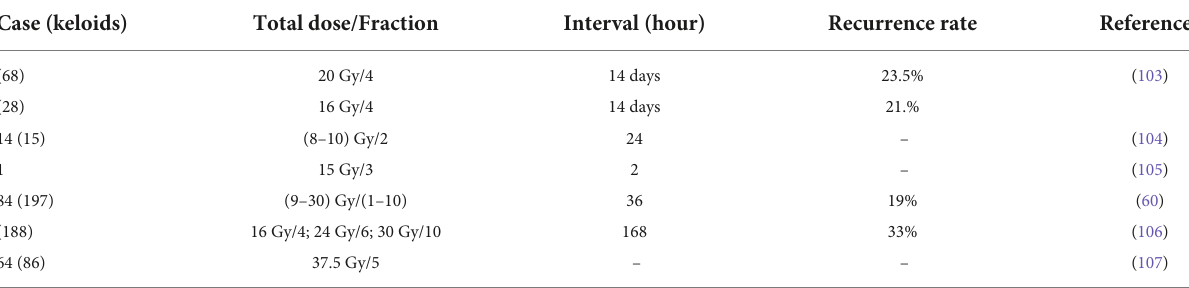
TABLE 1 Dose fractionation and recurrence rate of x-ray for